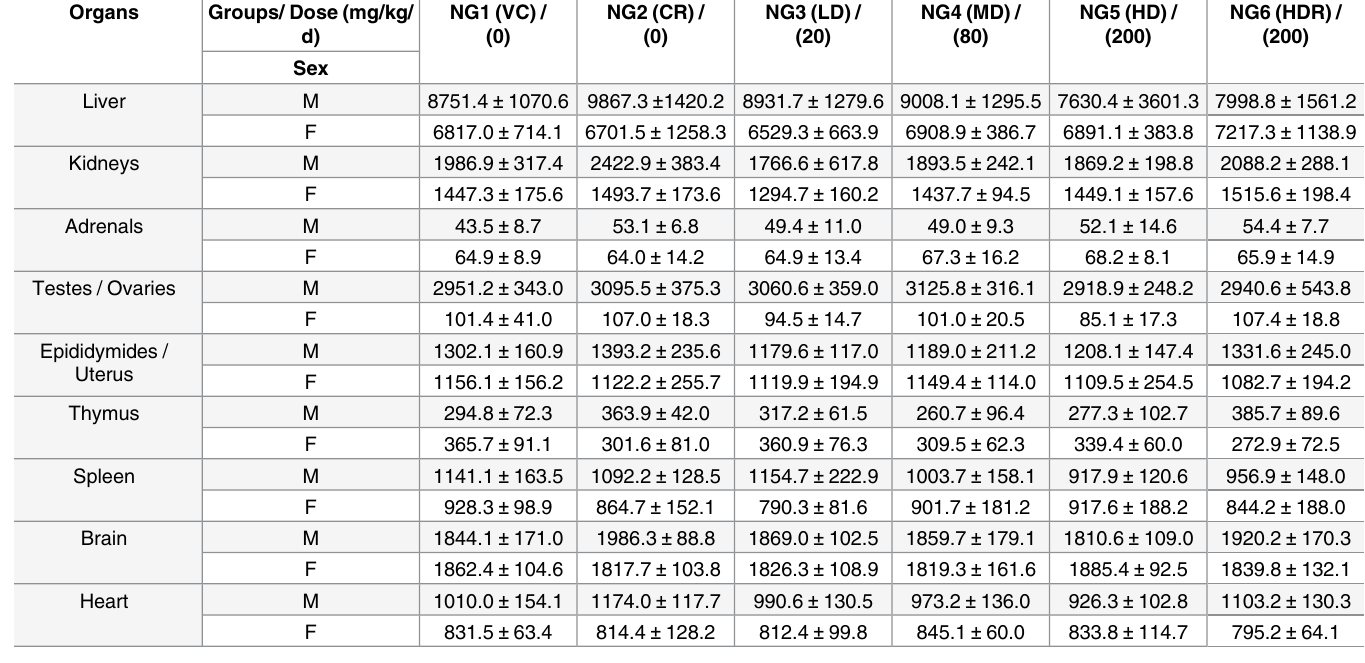
Table 5. Effect of 90 day oral administration of 3’-HPT on absolute organ weight (mg) of male and female SD rats. Organs